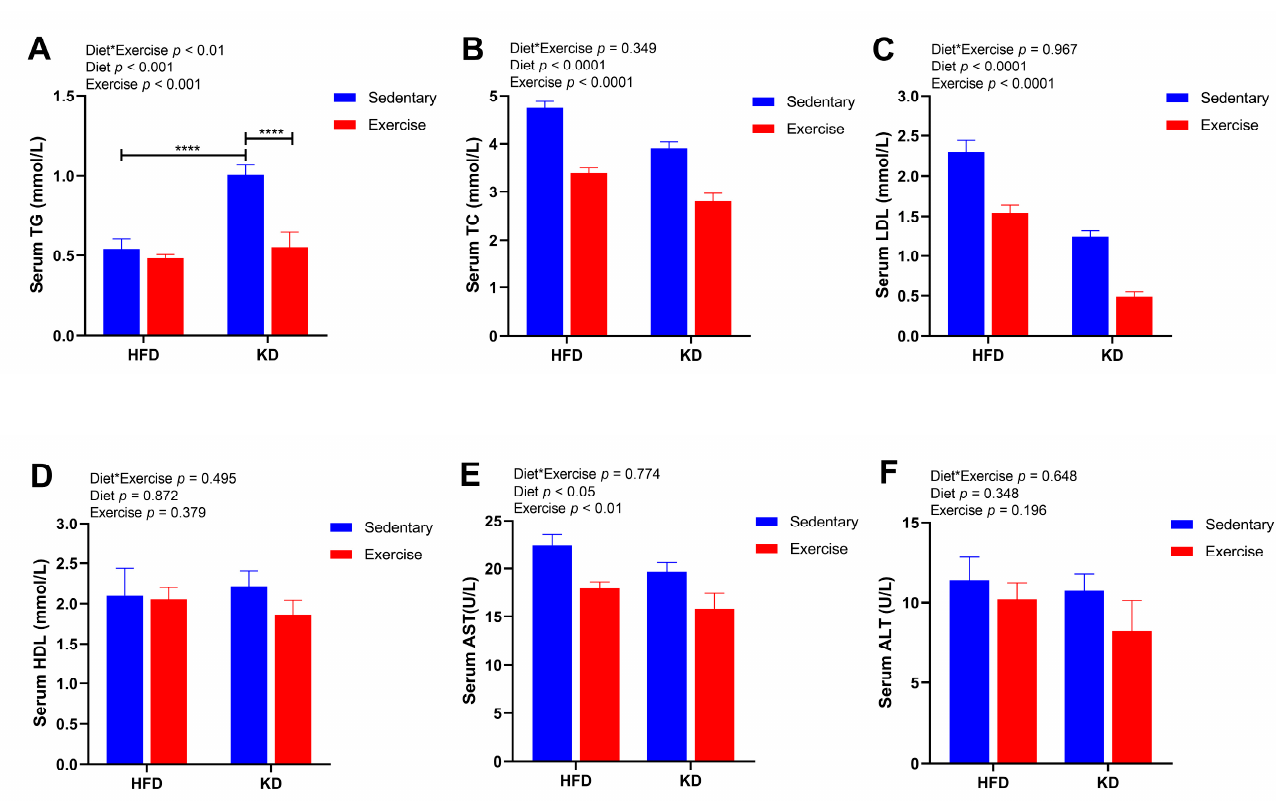
Figure 4. Effects of KD intervention and KD combined with exercise on serum lipid metabolism and liver injury in each group. ( A ) TG, ( B ) TC, ( C ) LDL, ( D ) HDL, ( E ) AST and ( F ) ALT in serum. Data are presented as mean ± SEM, n = 6–8. For panels ( A – F ), p values from the two-way ANOVA (i.e., main diet and exercise effects and diet*exercise interactions) are presented in the top left corner; Bonferroni post hoc test indicated significant differences (identified with an asterisk) at the following p values, **** p < 0.0001.